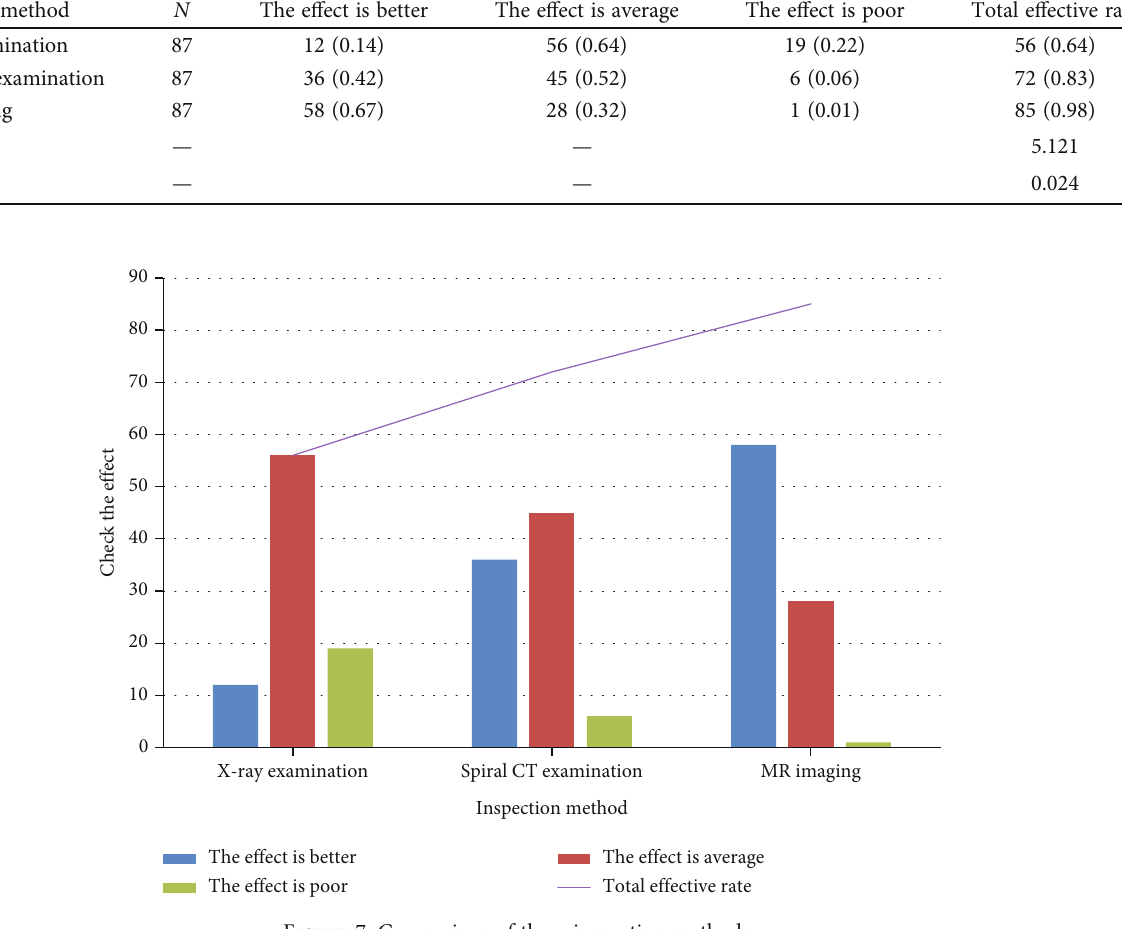
Figure 7: Comparison of three inspection methods. Table 6: Comparison of diagnostic accuracy of three methods.